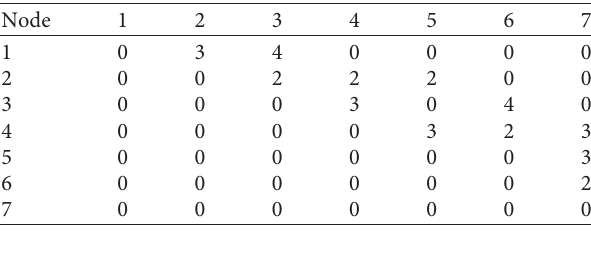
Table 2: Logistics network adjacency list (7